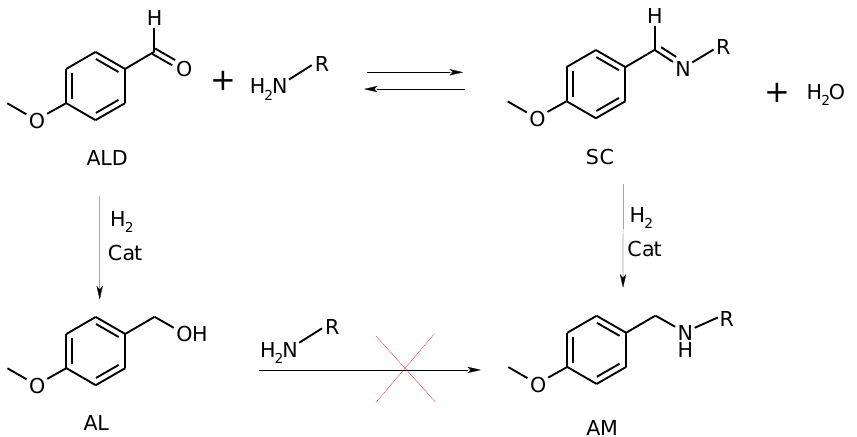
Scheme 1. Reaction scheme of amination of p -methoxybenzaldehyde with amine R-NH 2 , where n -butyl or benzyl. Reaction products: AM = N -substituted- N -( p -methoxybenzyl)amine, AL = p -methoxybenzyl alcohol, SC = Schiff base from p -methoxybenzaldehyde and amine. Table 2. The yields of the products in reactions of amination of p -methoxybenzaldehyde to H 2 in presence of Co-containing composites together with the yields of 1,2,3,4-tetrahydroquinoline (THQ) in hydrogenation of quinoline in presence of these composites.